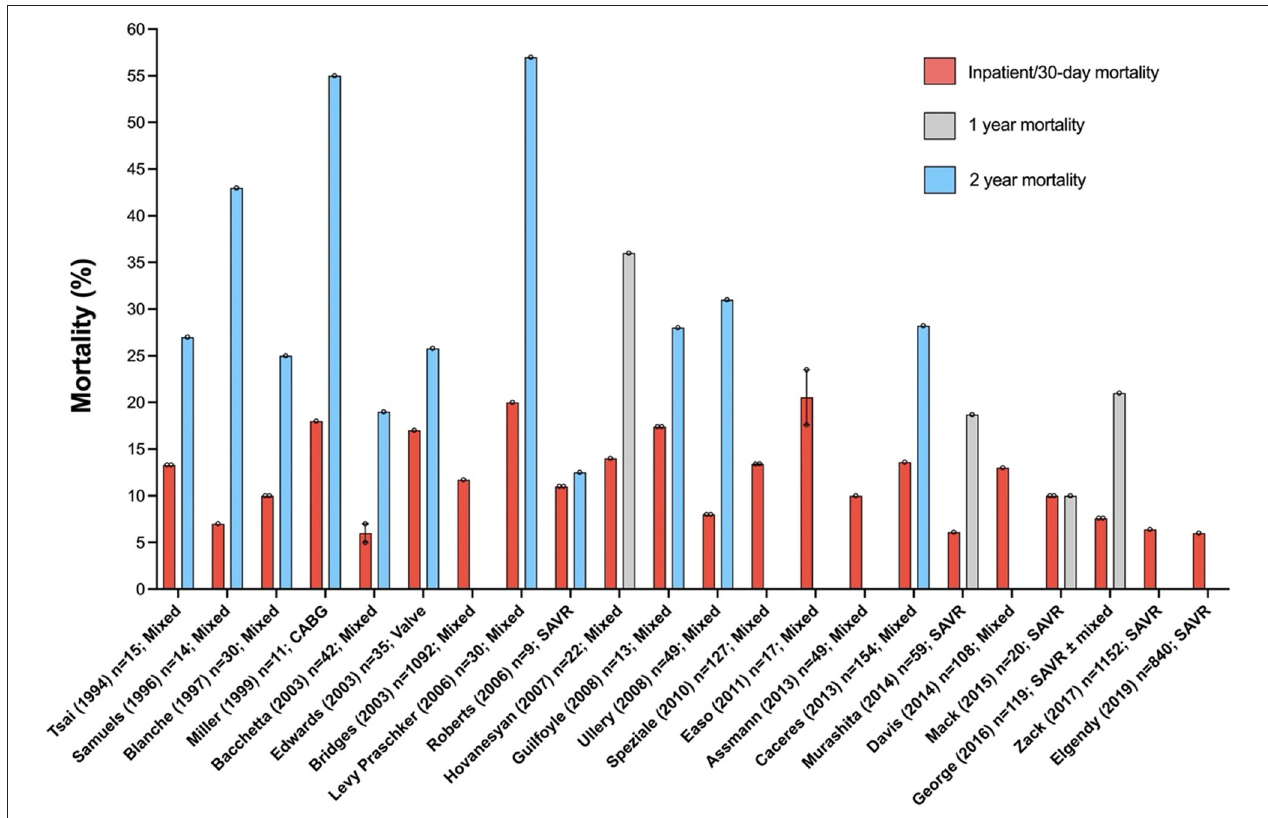
FIGURE 1 | Mortality in nonagenarians undergoing cardiac surgery. Excluded: single case reports, surgery on the thoracic aorta and reports where data could not be separated by age. Error bars represent mean ± standard error of the